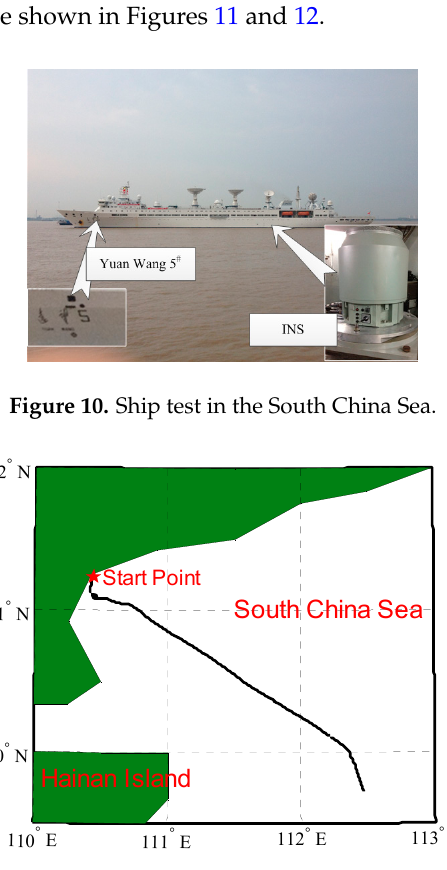
Figure 11. Trajectory of the ship test.